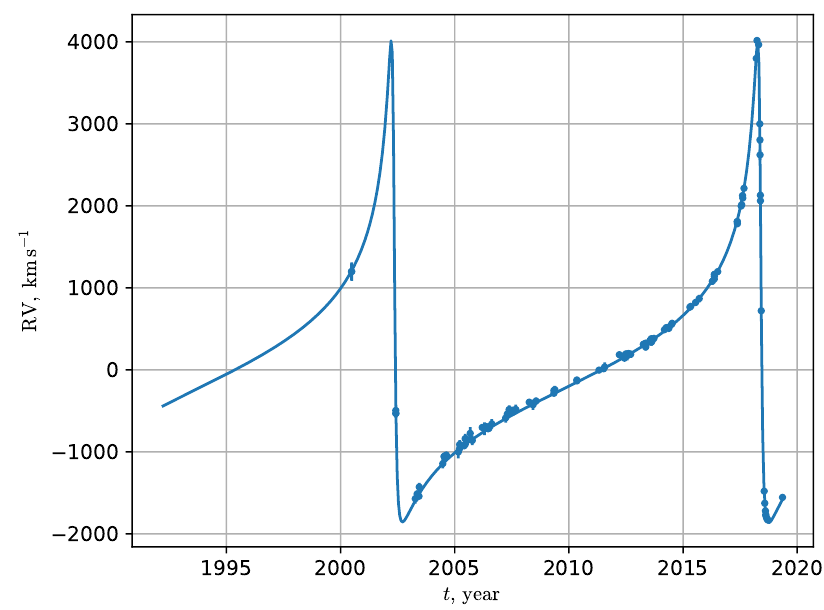
Figure 4. The RV plot of best-fit PPN orbit of S2.